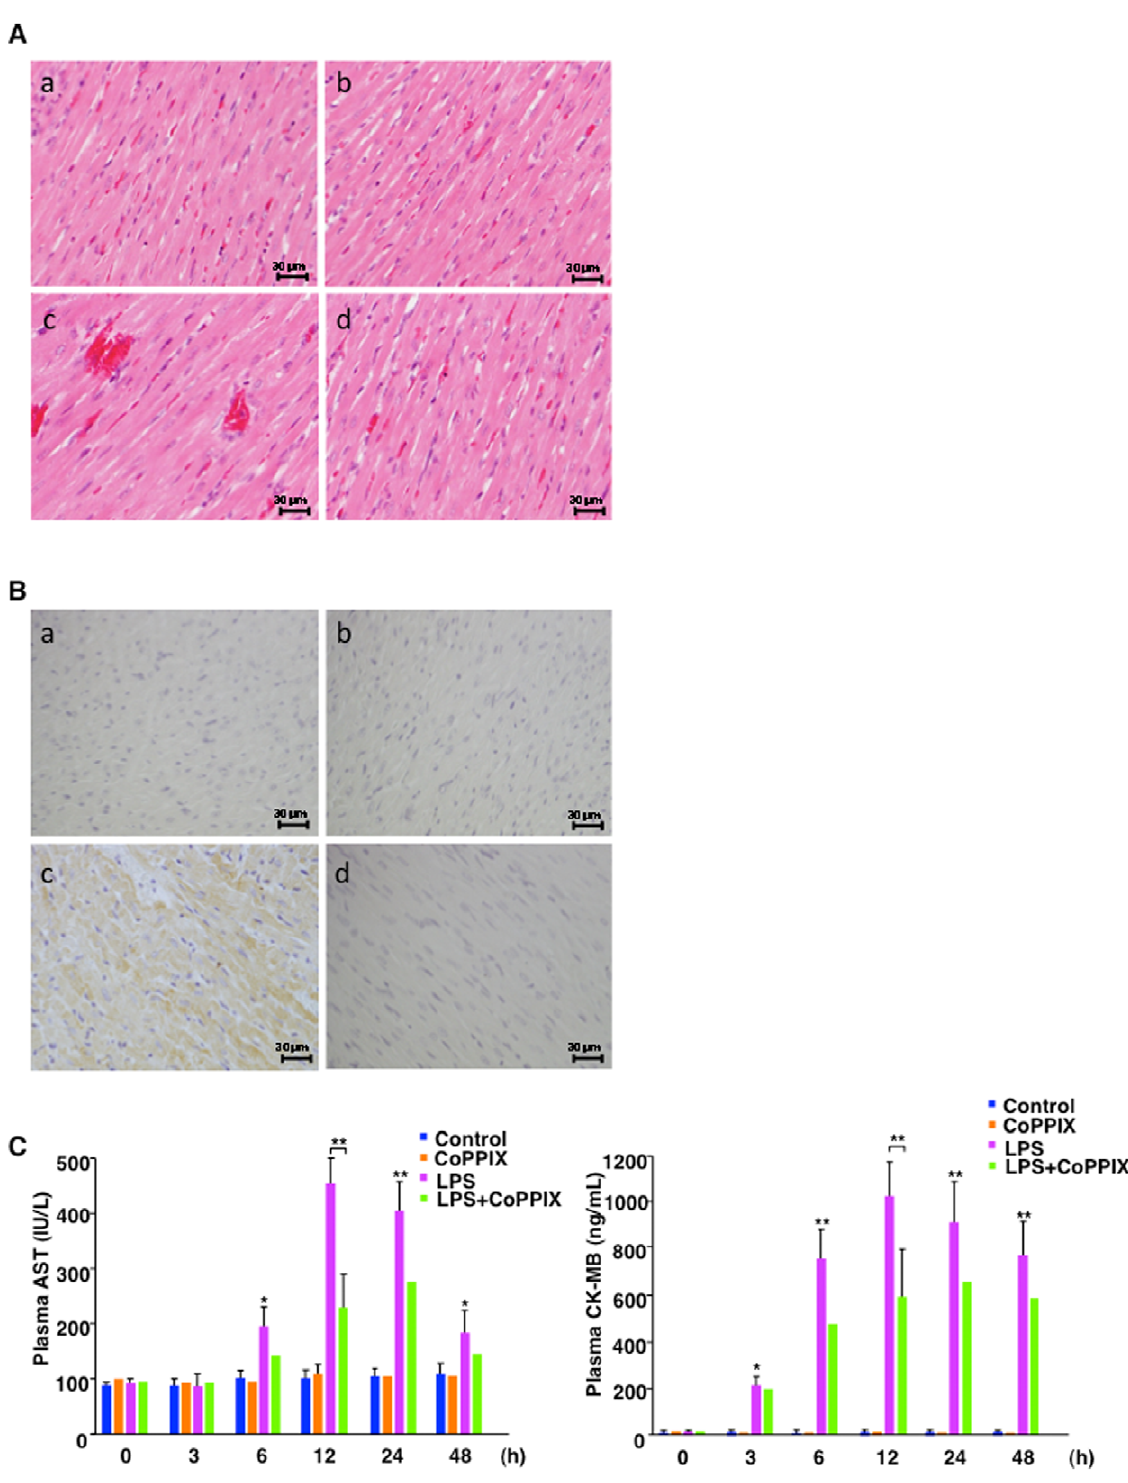
Figure 7. Histological and serological analyses of heart injuries during LPS administration in rats. A and B, Formalin-fixed and paraffin- embedded sections (3- m m thickness) of rat heart tissues stained with H&E and with anti-4-HNE antibody. Representative H&E stains (A, 6 400) and 4- HNE stains (B, 6 400) in each group (four animals) are shown: control (a), CoPPIX (b), LPS (c), LPS + CoPPIX (d) for 24 h. Bars, 30 m m. C, Plasma aspartate aminotransferase (AST, a) and creatine kinase-MB (CK-MB, b) concentrations for untreated control, CoPPIX (5 mg/kg, 24 h), LPS (15 mg/kg for indicated times), and LPS + CoPPIX groups. Values without error bars represent a single measurement while values with error bars represent mean 6 S.E. of four measurements (four animals). Statistical significance was determined between LPS and LPS + CoPPIX groups (12 h) or control and LPS groups (other time points) (** p , 0.01; * p , 0.05).